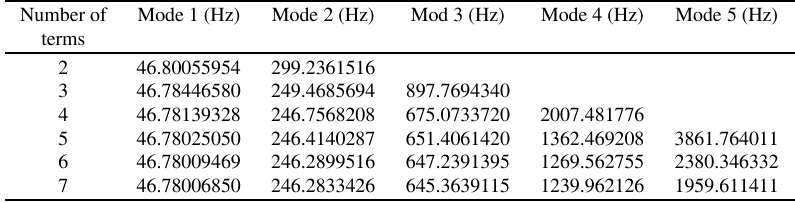
Table 9 Convergence of natural frequencies as a function of number of terms in the polynomial